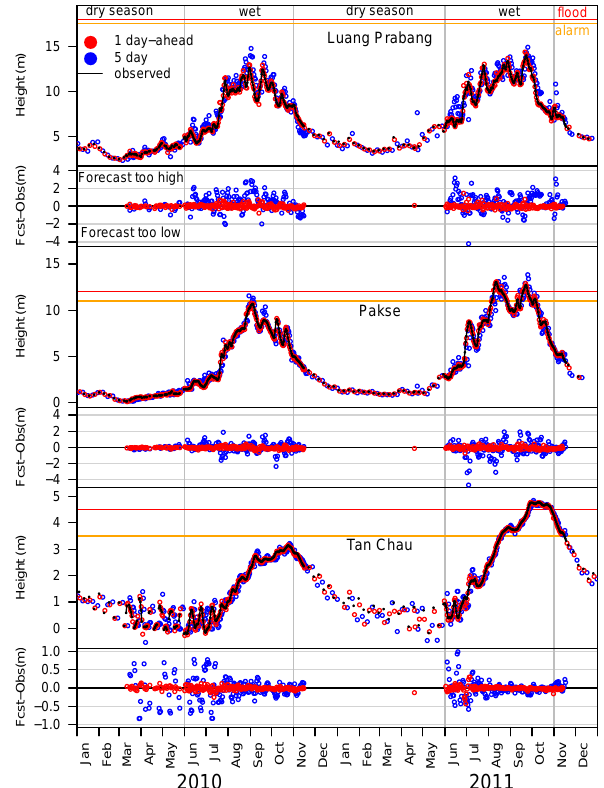
Figure 2. Time series of river height observations (black lines) and forecasts (colored dots) for Luang Prabang (top), Pakse (middle) and Tan Chau (bottom) for 2010–2011. Flood levels and alarm lev- els are horizontal lines, and vertical lines divide the wet and dry seasons. Below each plot of river heights is a plot of forecast errors (forecast –